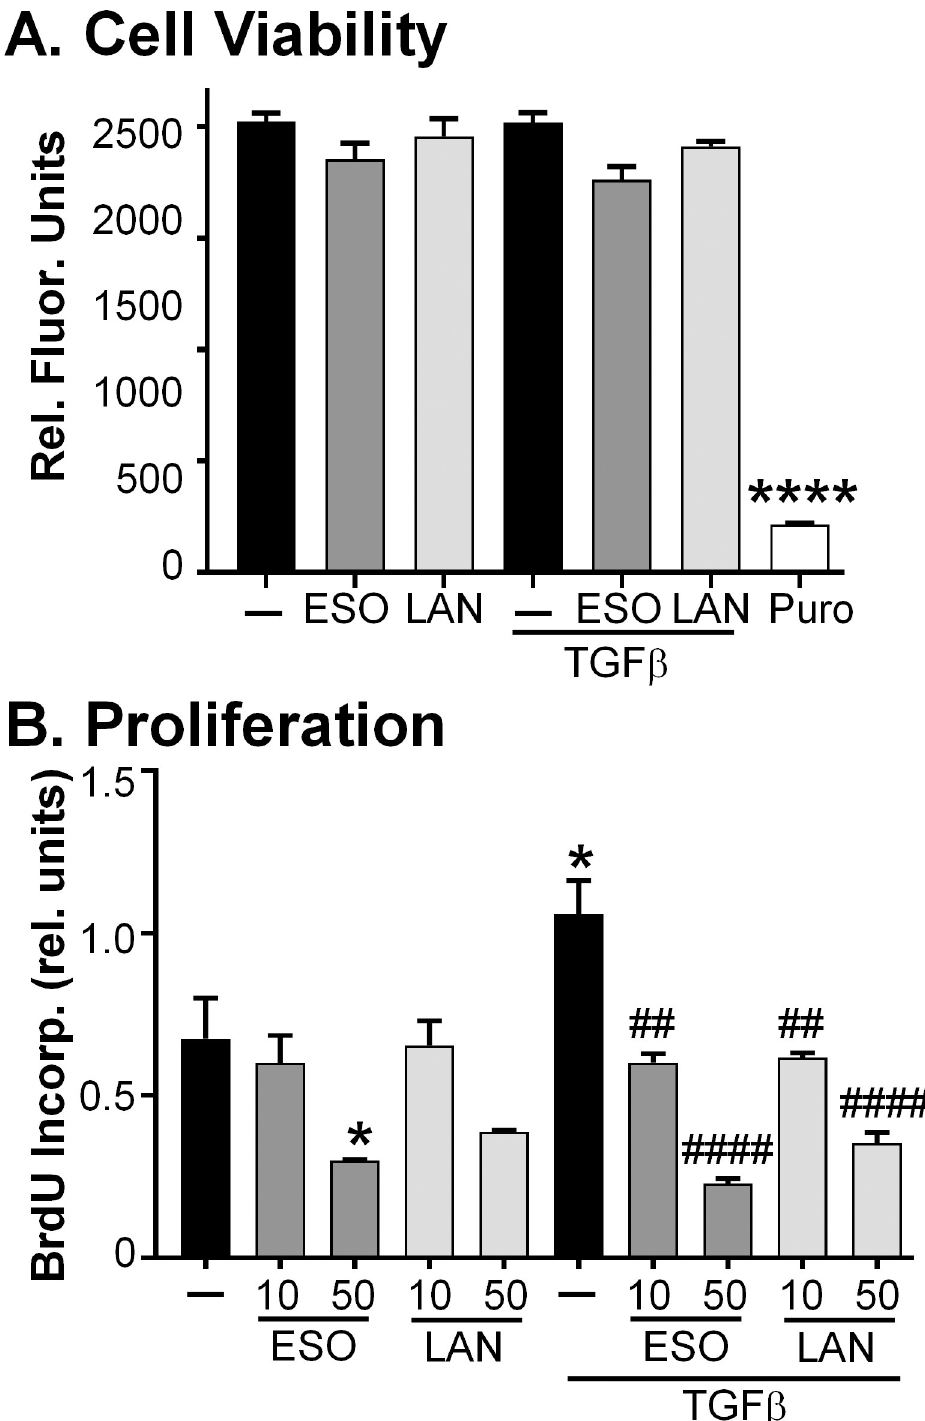
Fig 5. PPIs do not reduce TED orbital fibroblast cell viability; however, they do reduce fibroblast proliferation. A) PPIs (ESO = esomeprazole; LAN = lansoprazole; 50 μ M dose) were added to cell cultures every 24h for 96h. TGF β (1 ng/mL) was added 24h after the first PPI dose. Cell viability in TED orbital fibroblasts was measured using the Alamar Blue assay. PURO = Puromycin, a positive control for cell death. N = 3 different TED orbital fibroblast strains. ���� p < 0.0001; significantly different from all other treatments measured with a one-way ANOVA and Tukey’s post hoc analysis. B) Cells were treated with PPIs (ESO = esomeprazole; LAN = lansoprazole; 10 and 50 μ M doses) for 2h before